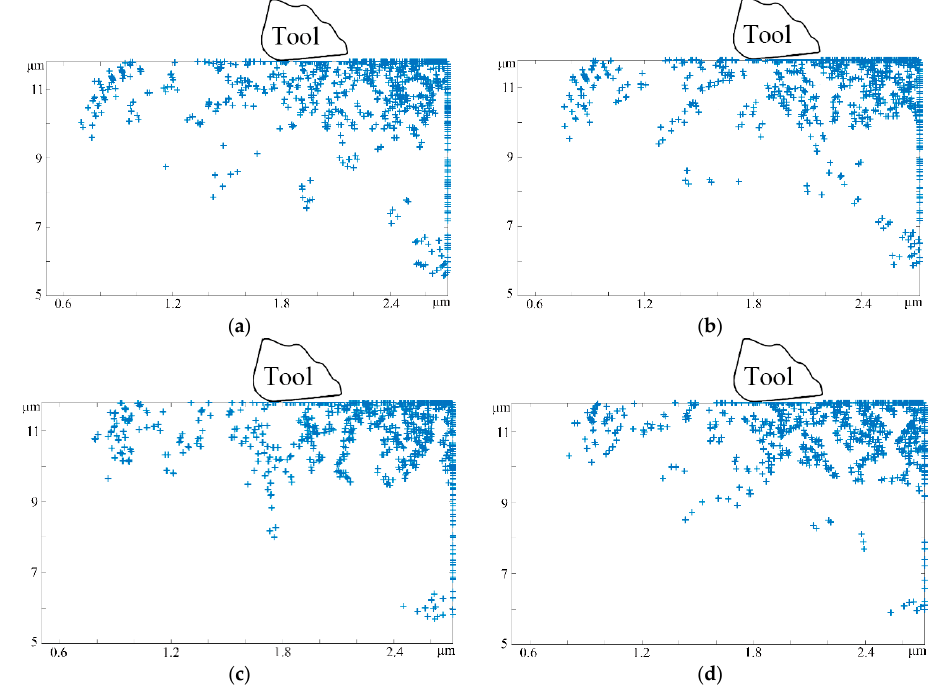
Figure 4. The subsurface defects microstructural evolution with different rake angles (cutting distance 10 µ m, cutting speed 10 m/s, cutting depth 1 µ m, tool edge radius 0.25 µ m, and clearance angle 15 ◦ ). ( a ) rake angle 1 ◦ ; ( b ) rake angle 3 ◦ ; ( c ) rake angle 5 ◦ ; ( d ) rake angle 10 ◦